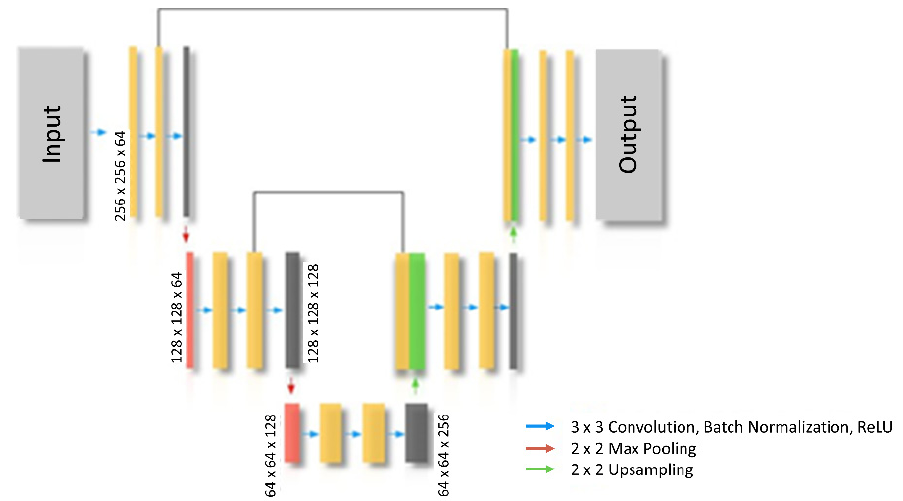
Figure 3. The generator network structure. Yellow blocks represent convolutional layers with a kernel size 3 × 3, with ReLu as an activation function followed by batch normalization. Red blocks represent the max pooling layers. The black blocks represent residual blocks that includes two convolutional layers with kernel size 3 × 3 . Green blocks represent the layer upsampled from the output of the previous residual block. The dimension of the layer represents the size and number of the input channels. The different calculation processes are represented by arrows with different colors, which are listed at the right foot of the figure. The size of the input image is 256 × 256, and the output size of the reconstructed image is 256 × 256.